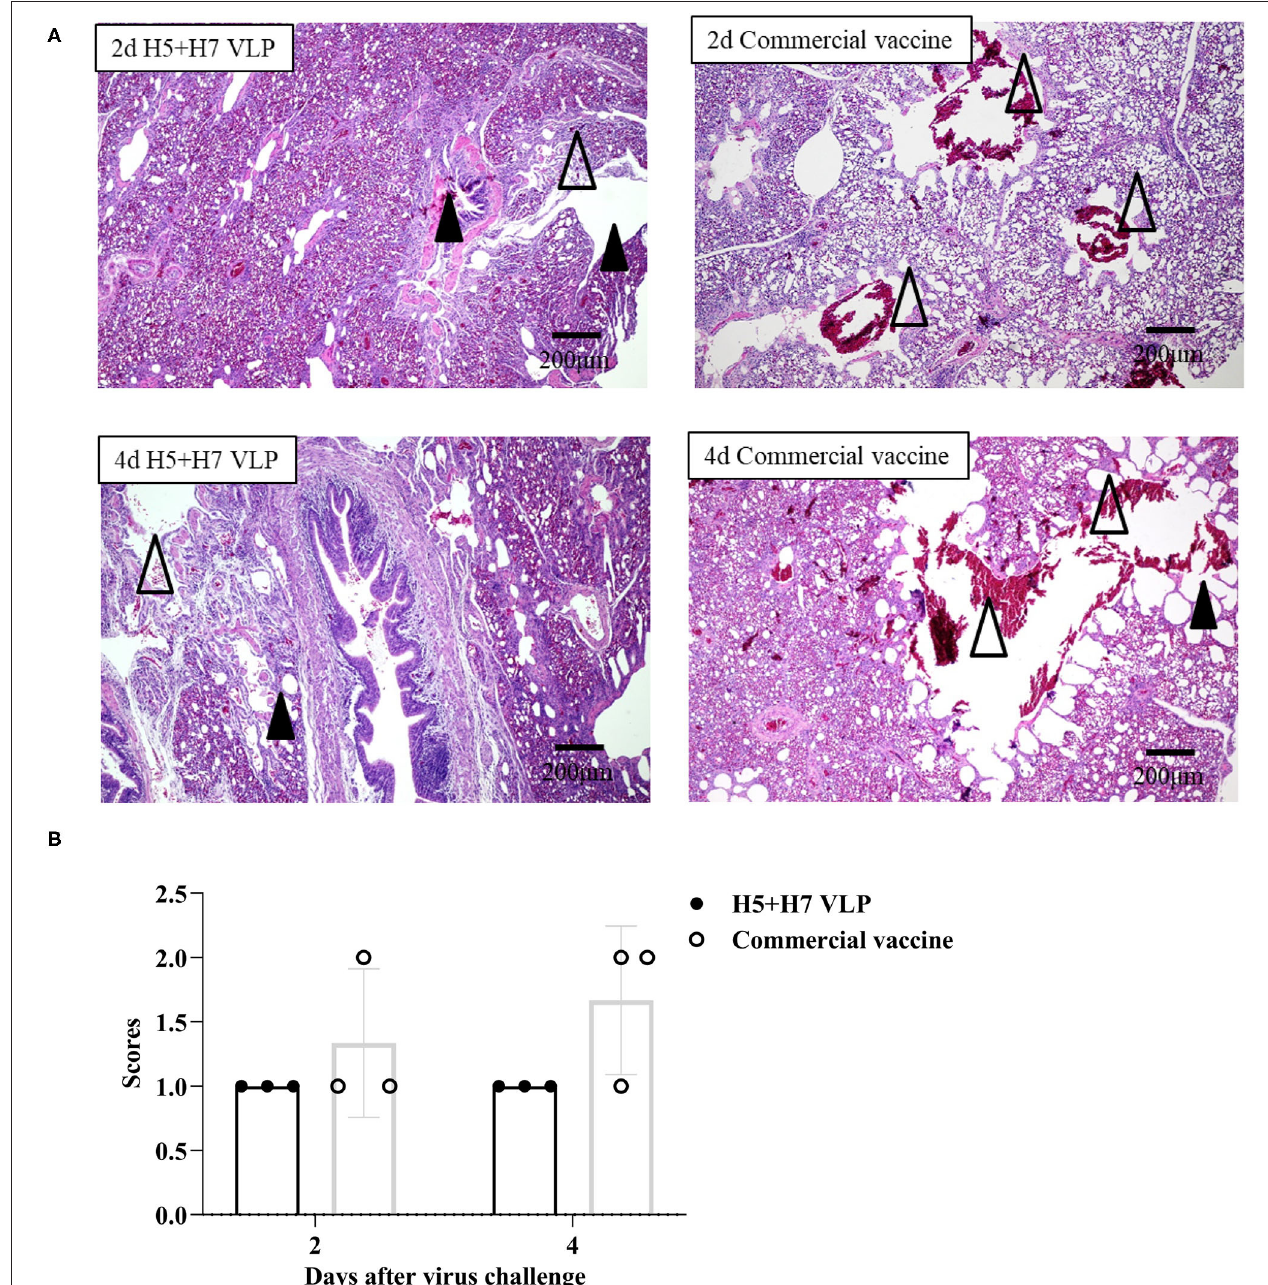
FIGURE 6 | The bivalent H5 + H7 VLP vaccine inhibits lung pathological changes after the lethal H5N1 virus challenge. (A) Hematoxylin and eosin (H & E) staining results of the birds’ lung on Day 2 and 4 post-H5N1 virus challenge. Black triangle indicates dilatation in the pulmonary chamber or bronchial; white triangle arrow stands for infiltration of fiber cells, detached epithelial cell mucus, and erythrocytes in the parabrochus. (B) Scores of the overall histopathologic changes in the bird’s lung post-H5N1 virus challenge. The specific information concerning the scoring criteria was listed in the Materials and Method section.